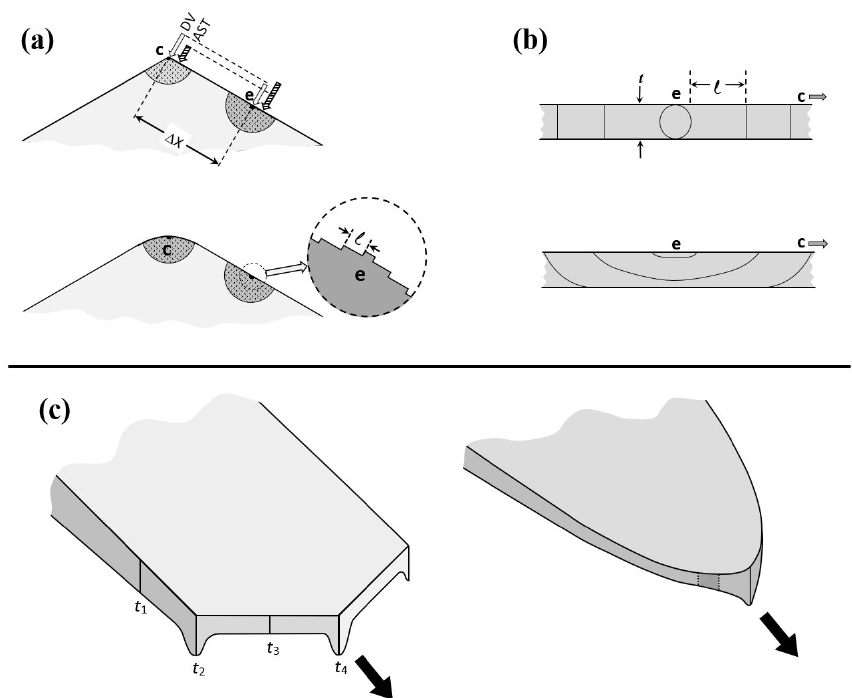
Figure B8. AST-induced rounding. (a) Direct vapor flux DV and AST at the corner c and edge e of a thin tabular crystal. Shaded regions are effective collection regions for AST flux; arrows show relative magnitudes. Inset at the bottom is shown in the top case of (b) from an edge-on view. (b) Nucleation and step flow on edge region of thin crystal in (a) ; plan view of edge. Top sketch is symmetric case. Layer nucleation point e of (a) has steps moving away with initial separation l . Bottom sketch shows asymmetric case leading to step separation l ∼ t . (c) Thin-branch case with non-crystallographic backside. Thickness t is greater at the vertices t 2 and t 4 and thus has less growth from AST flux. Rounded case on the right with small prism face bound by dotted